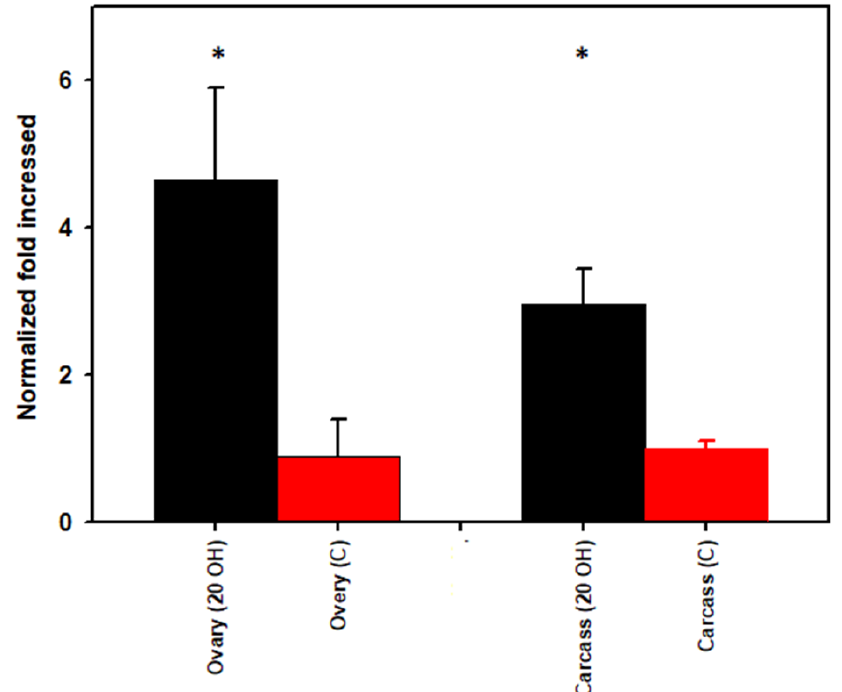
Figure 2. Total bacterial load (qPCR using the 16S gene target) in part-fed (virgin) Dermacentor variabilis ovaries versus carcass for 20-hydroxyecdysone (20E) versus control buffer (C) injected ticks. Mean fold change ± SEM, * p < 0.05.